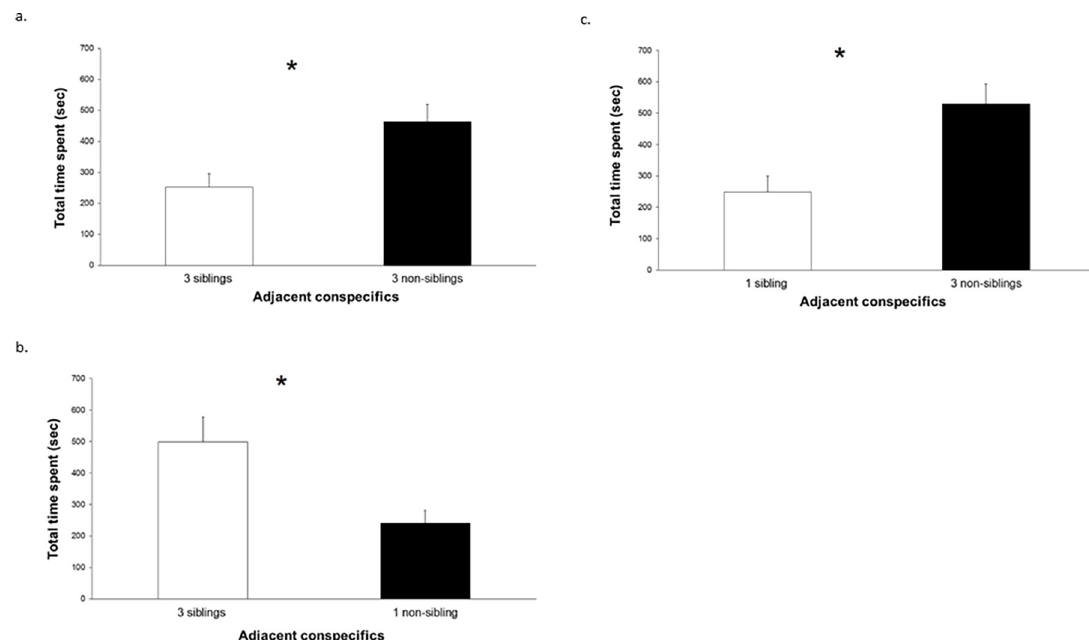
Fig 2. Total time spent (in seconds; mean ± s.e.) by a focal larva during 30 min sessions, in the experimental aquarium, within 2 cm away from adjacent conspecifics, when they were in: (a) Experiment A: three siblings in one side chamber versus three non-siblings in the other side chamber, (b) Experiment B: three siblings in one side chamber versus one non-sibling in the other side chamber, and (c) Experiment C: one sibling in one side chamber versus three non-siblings in the other side chamber. The side chamber in which these conspecifics were housed within each of the three experiments was randomly alternated between the right and left chambers. In each of the three experiments, mean is shown for each of the two groups of conspecifics averaged across the two side chambers (right or left). An asterisk ( � ) denotes a significant difference (P < 0.05; sign test ) between the time spent near the two groups of